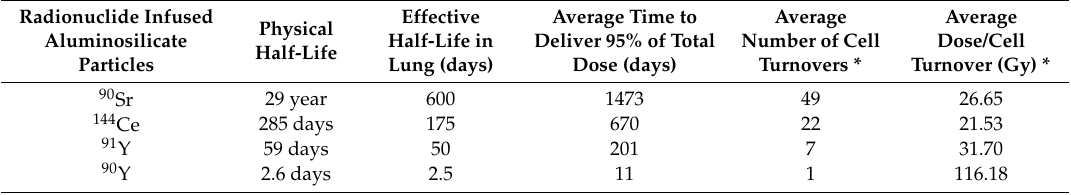
Table 1. The half-lives, time to deposit 95% of total dose of radionuclides, and average dose/cell turnover. Radionuclide Infused